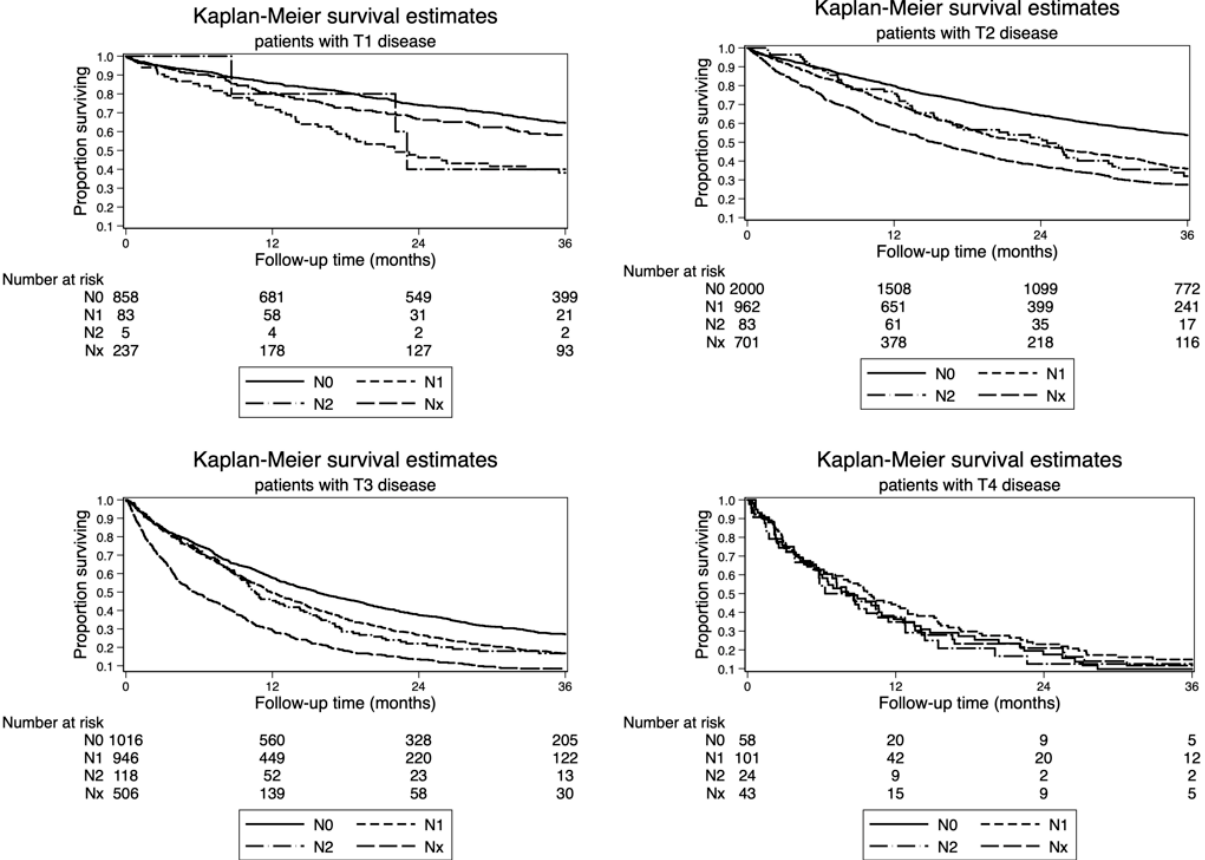
Figure 2. Impact of nodal disease on overall survival (OS) stratified by T-stage (Kaplan–Meier method) according to the AJCC 8th edition TNM classification. Table 3. Impact of nodal disease on overall survival (OS) stratified by T-stage. CI, confidence interval.